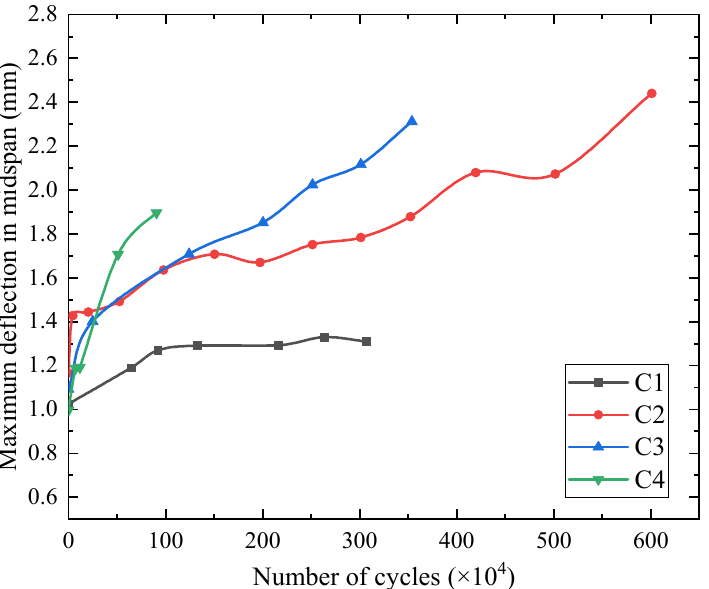
Figure 10. The relationship between the number of cycles and midspan displacement.